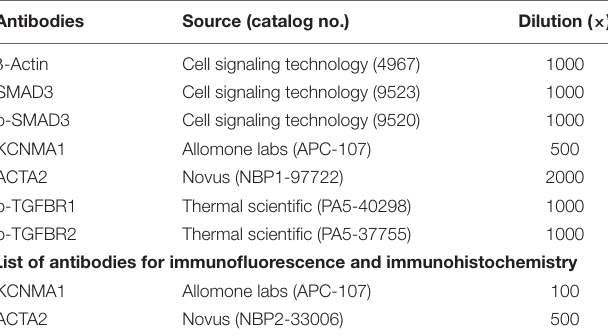
TABLE 3 | List of antibodies for western blotting